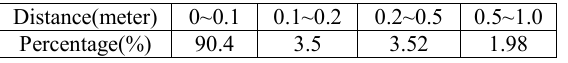
Table 2. Distribution of distance between two point clouds Given the collecting time of robot-borne system and TLS is different in the campus where the cars and trees differ a lot over time, we only registration two datasets to evaluate the results qualitatively. The registration results are shown in Figure 8 (a). As it can be seen from the Figure 8 (b), the columns collected by our system have a good geometric shape and match the high- precision point clouds highly.